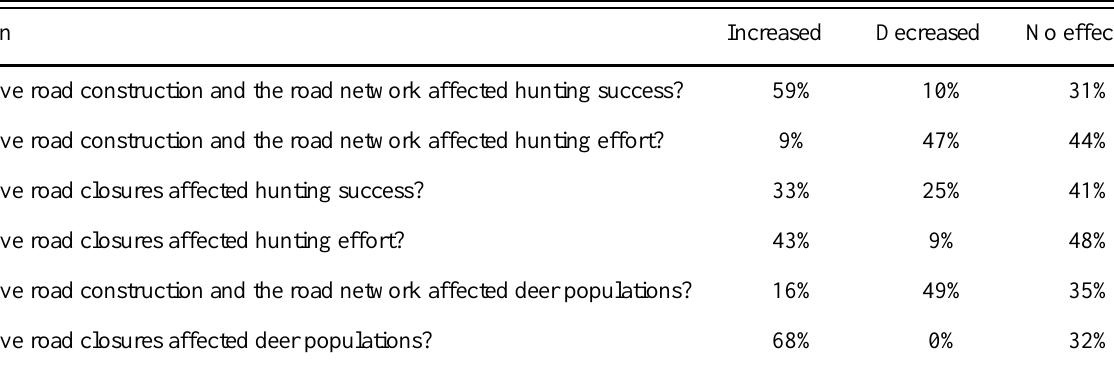
Table 3 . Responses by percentage from deer hunters interviewed on Prince of Wales Island, Alaska, to questions addressing the influence of roads and road closures on hunting success, hunting effort, and deer population